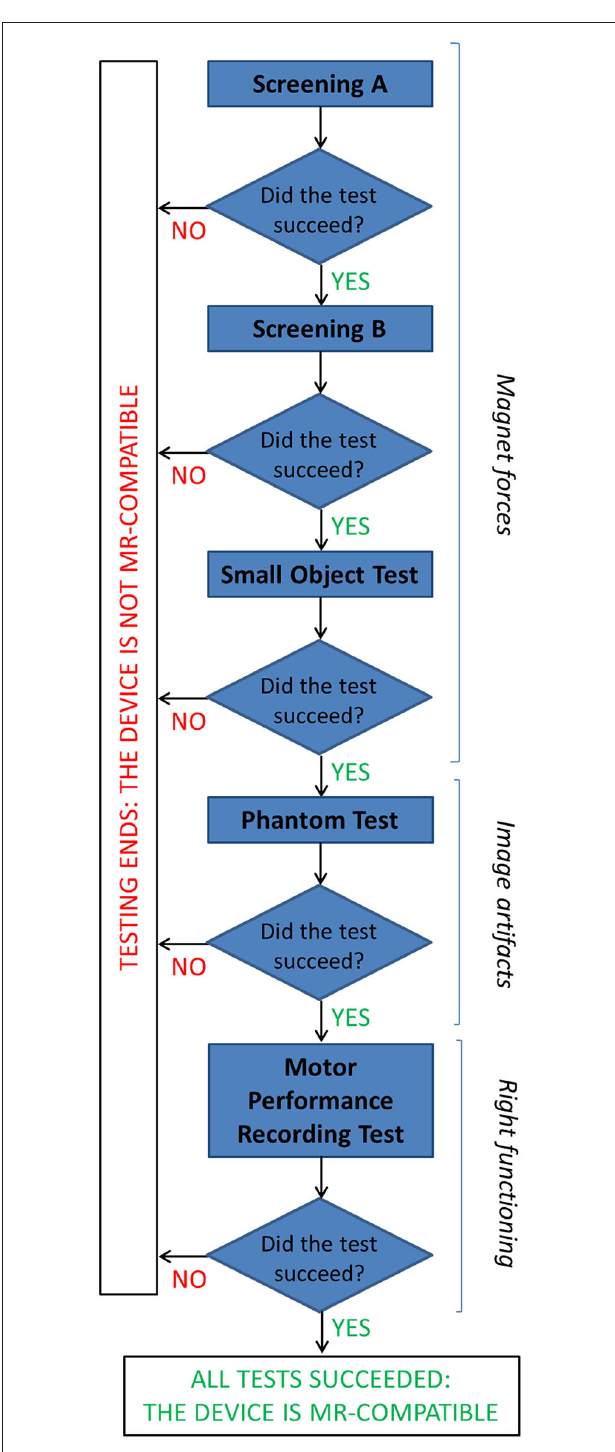
FIGURE 2 | The flow chart describes the tests performed to assess MR compatibility of the GAF system (details are reported in the text).